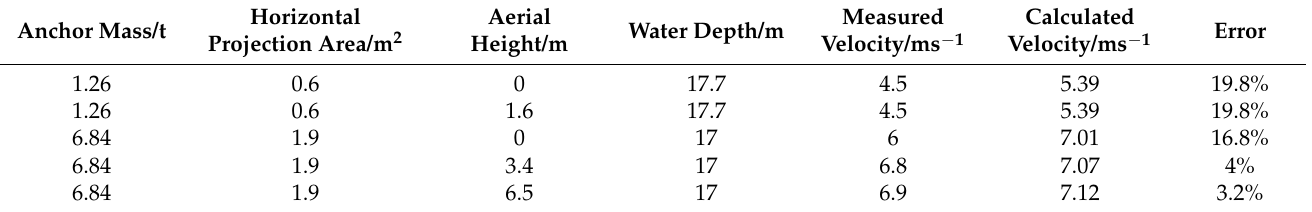
Table 1. The comparison of the bottoming velocity of the measured data and the calculated